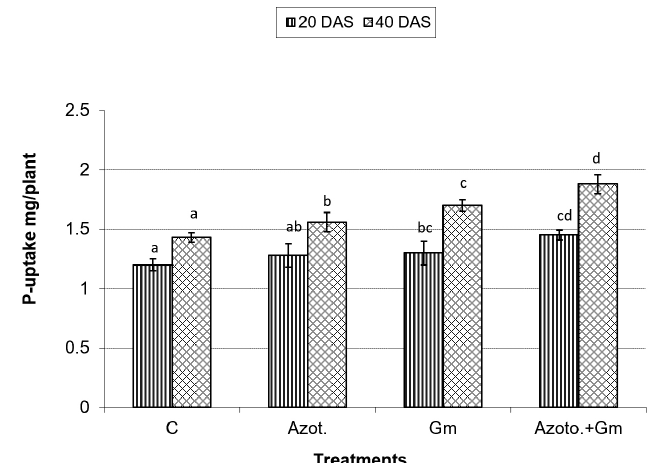
Fig. 3. Phosphorus uptake of onion plants as influenced by inoculation with Glomus moseae (Gm) and Azotobacter chroococcum (Azoto.), 20 and 40 days after planting